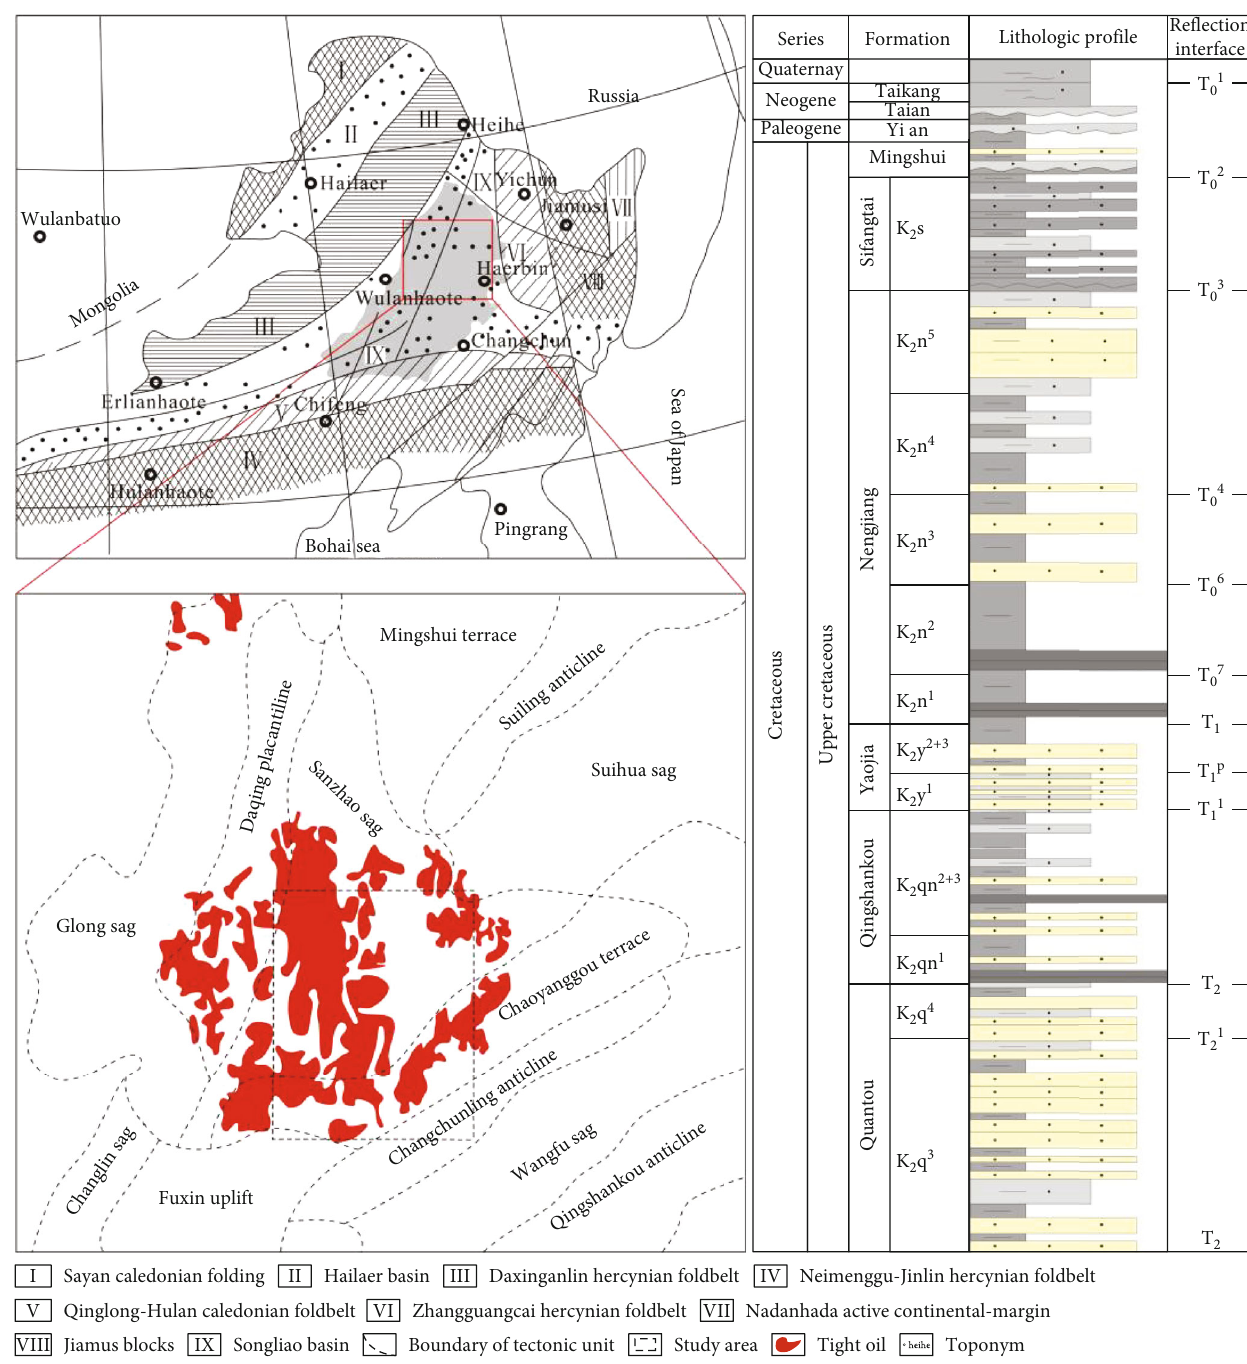
Figure 1: Location of the study area and distribution of tight